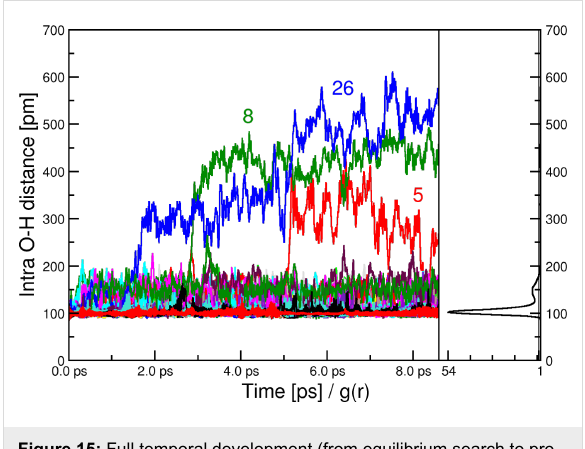
Figure 15: Full temporal development (from equilibrium search to pro- duction run) of all 32 intramolecular O–H distances in the SO 3 H group (left) along with the radial pair distribution function of the same atom pair (right). The numbers refer to the molecules in the simulation box.